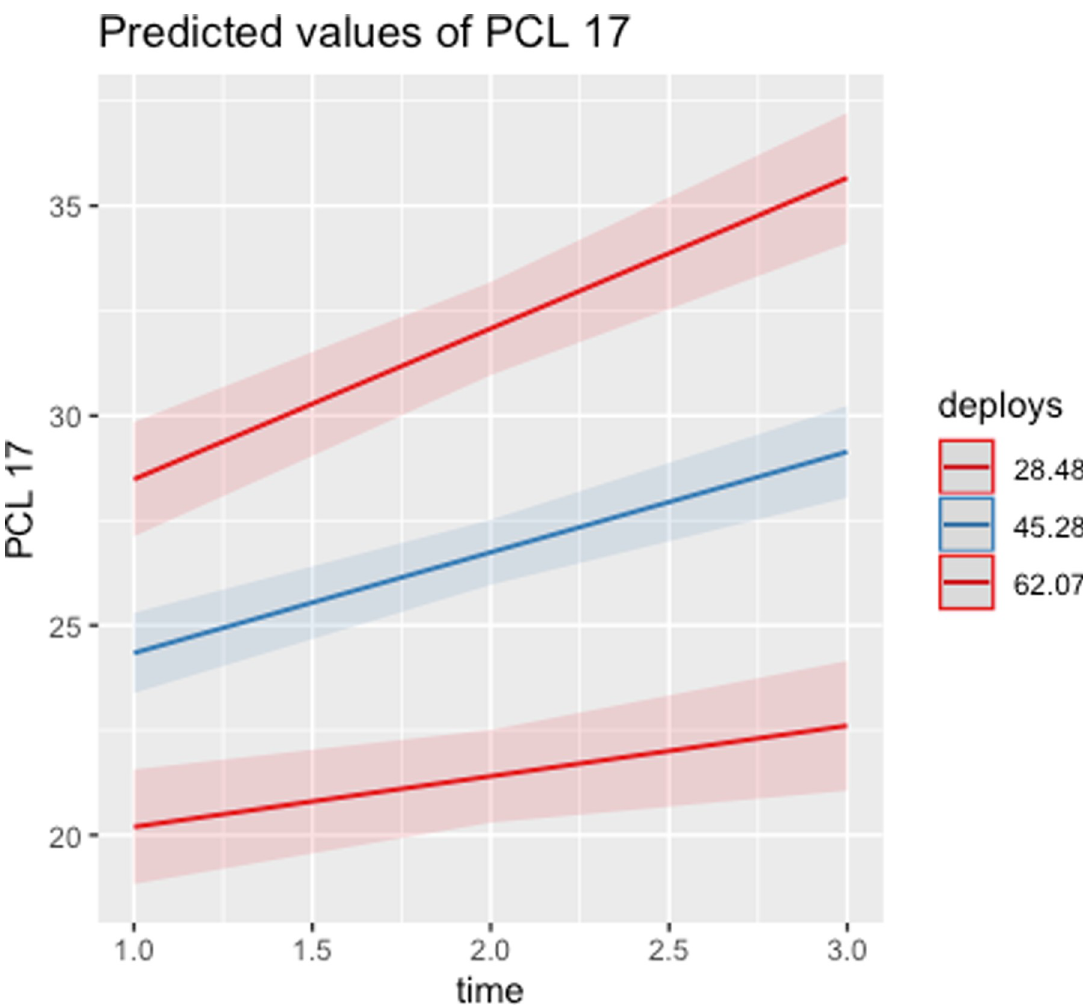
Fig 4. Predicted values of PCL-17 across time as a function of deployment